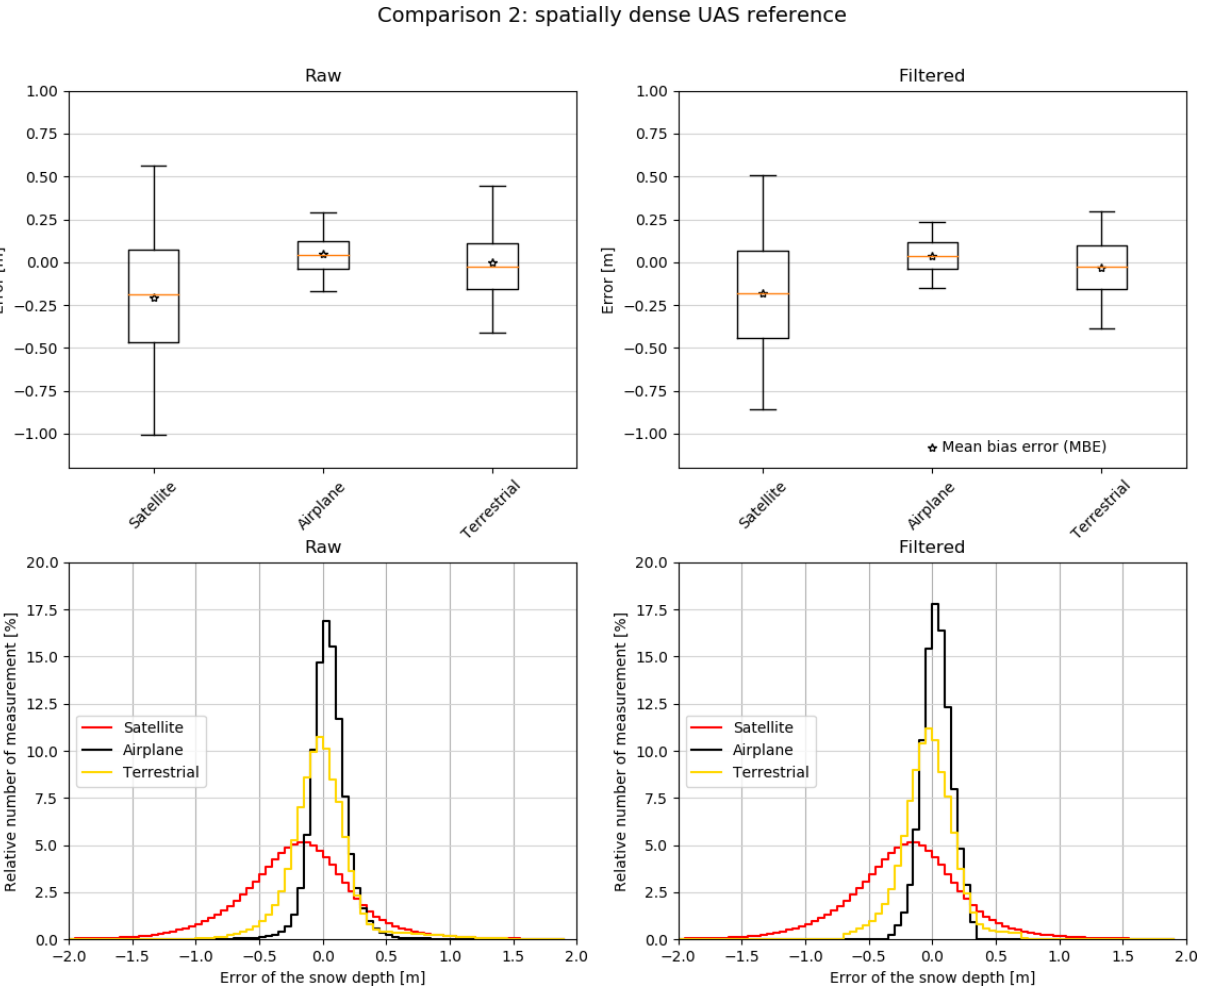
Figure 8. Box plot of comparison 2. The orange line depicts the median, the star the mean bias error (MBE). The 25th and 75th quartiles are represented by the boxes and the 5th and 95th percentiles by the whiskers. The upper-left box plot shows the raw data and the upper-right box plot the data where plus or minus 2 SDs are removed from the raw data. To better illustrate the distribution of the error, we calculated normalized histograms for the raw and filtered data. The bottom-left plot shows the raw data and the bottom-right plot the filtered data. Table 5. Accuracy and precision assessment for comparison 2: the column “Raw” contains the accuracy measures for all the values, and the column “Filtered” shows the results of the accuracy measures where any values exceeding the threshold of plus or minus 2 SDs are removed. For the satellite data, 4.2% of the data were removed with the filter, while 4.9% of the airplane data and 4% of the terrestrial data were